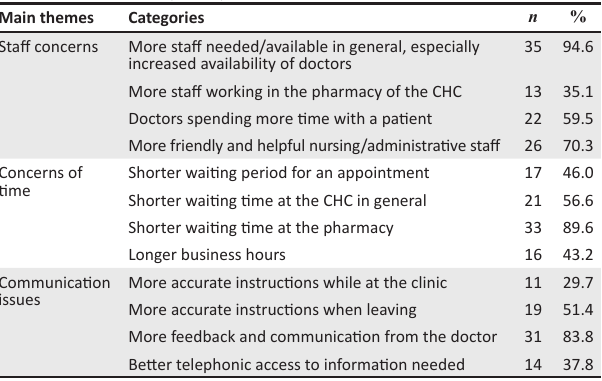
TABLE 3: Summary to open-ended question: Any suggestions for improvement of services at the CHC ( n =